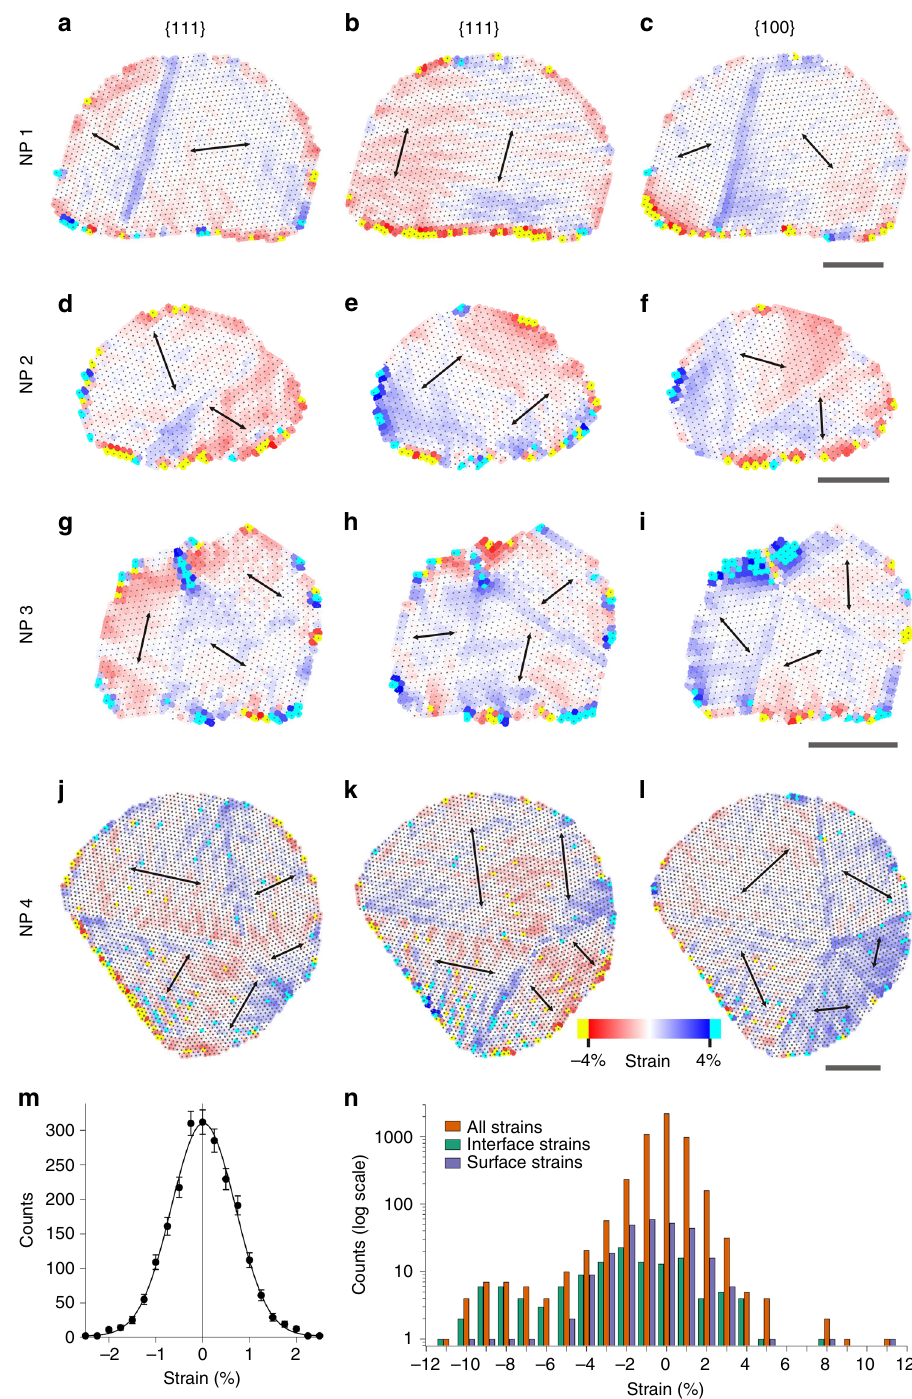
Fig. 2 Atomic resolution strain behaviour of supported Pt NPs. a – l Atomic resolution strain maps within three crystallographic planes, as indicated above the NPs. The colour scale indicates variations in nearest-neighbour separations spanning from − 4% (red, compressive) to 4% (blue, expansive). Strains above these thresholds are highlighted in yellow (compressive) and turquoise (expansive). Each scale bar corresponds to 3 nm. m Strain histogram from the unstrained reference area of NP 1, demonstrating <0.7% strain precision. The error bars correspond to the square root of the number of counts. n Strain histogram from the whole NP 1, vacuum surface and the NP – alumina